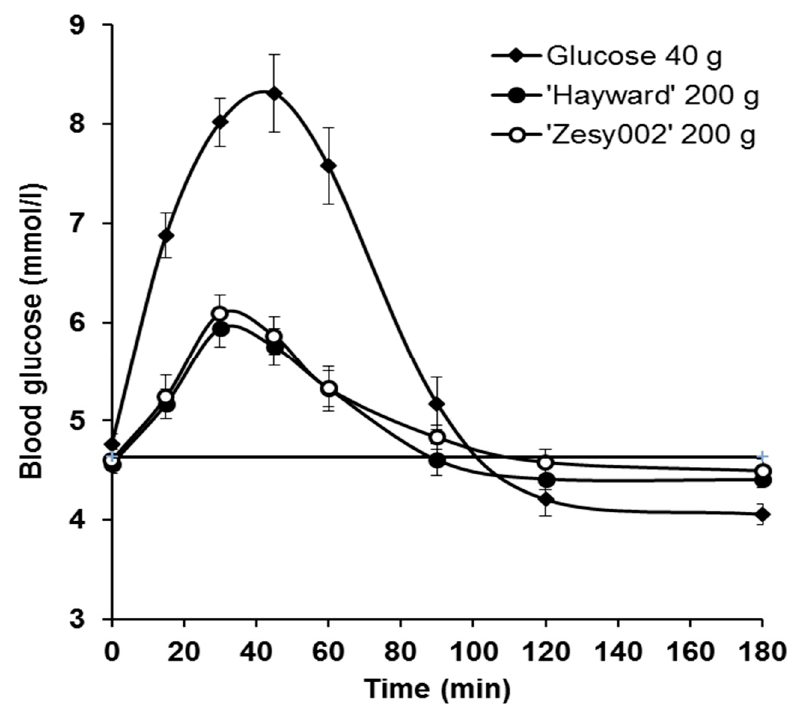
Figure 2. Mean ( ± SEM) blood glucose responses used to determine the relative glycaemic potency of “Hayward” (GR) and “Zesy002” (SunGold, SG) kiwifruit.